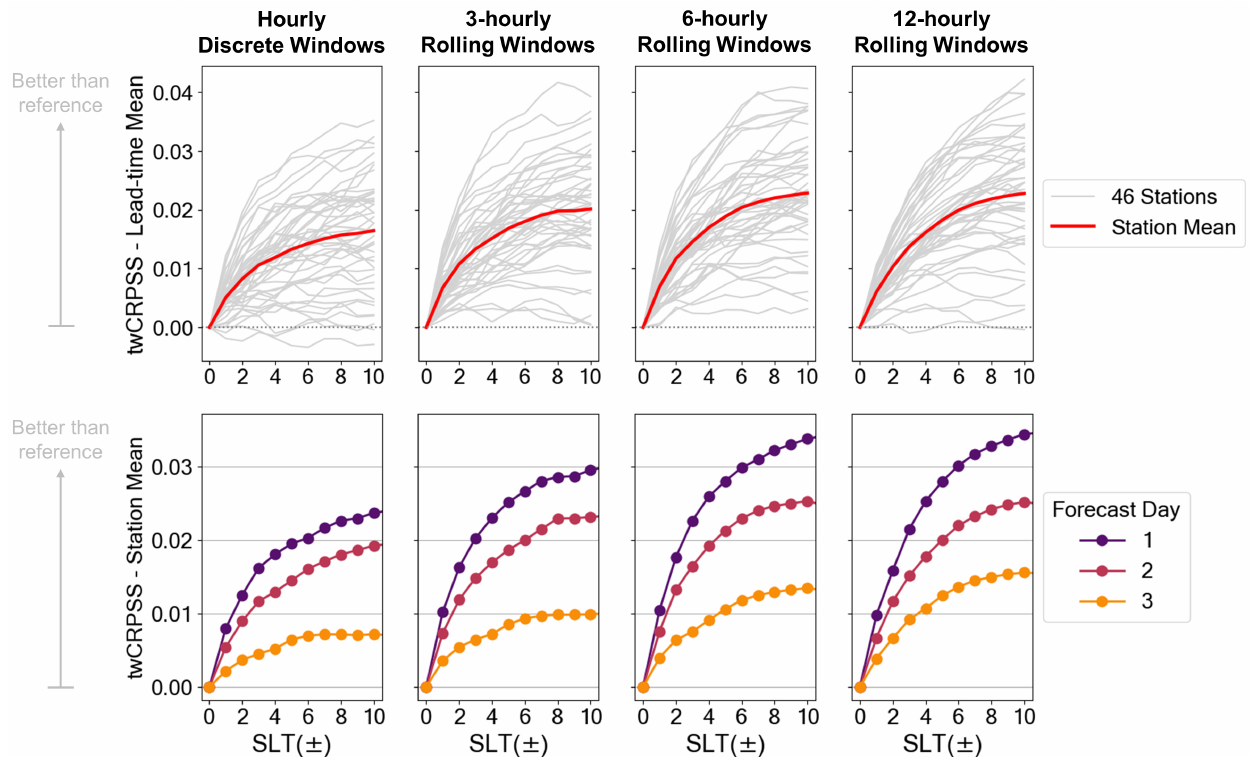
Figure 7. Lead-time aggregated ( top ) and station-aggregated ( bottom ) twCRPSS from the supplemental- lead-time (SLT) experiments. The reference for twCRPSS is the original approach with optimized predictors but without SLT. Positive twCRPSS indicate improvement compared to the